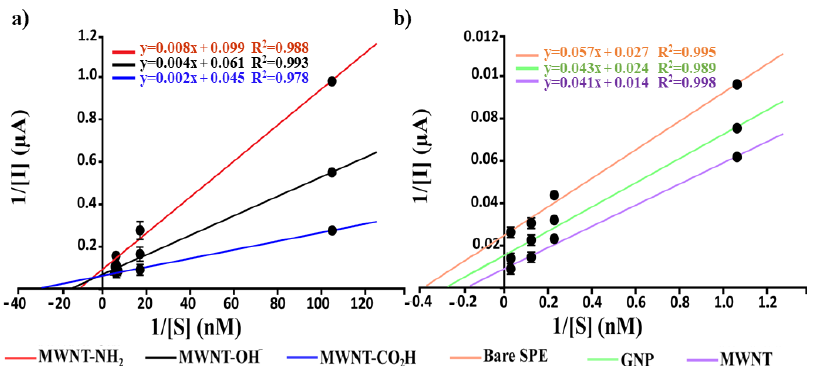
Figure 6. ( a ) Lineweaver–Burk plots obtained using ( a ) functionalized CNMs (MWNT-OH, -CO 2 H, and NH 2 ) and ( b ) GNP, Bare MWNT and bare SPE based biosensors in the presence of an increasing concentration of uric acid.